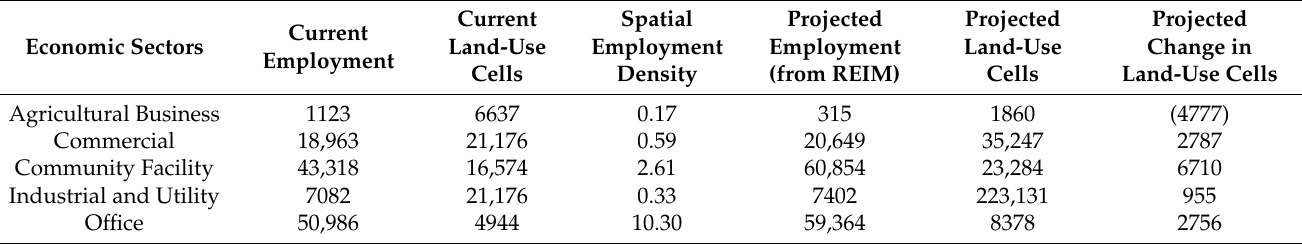
Table 1. Spatial employment density of Sangamon County and projection for land-use cell number change based on an economic investment